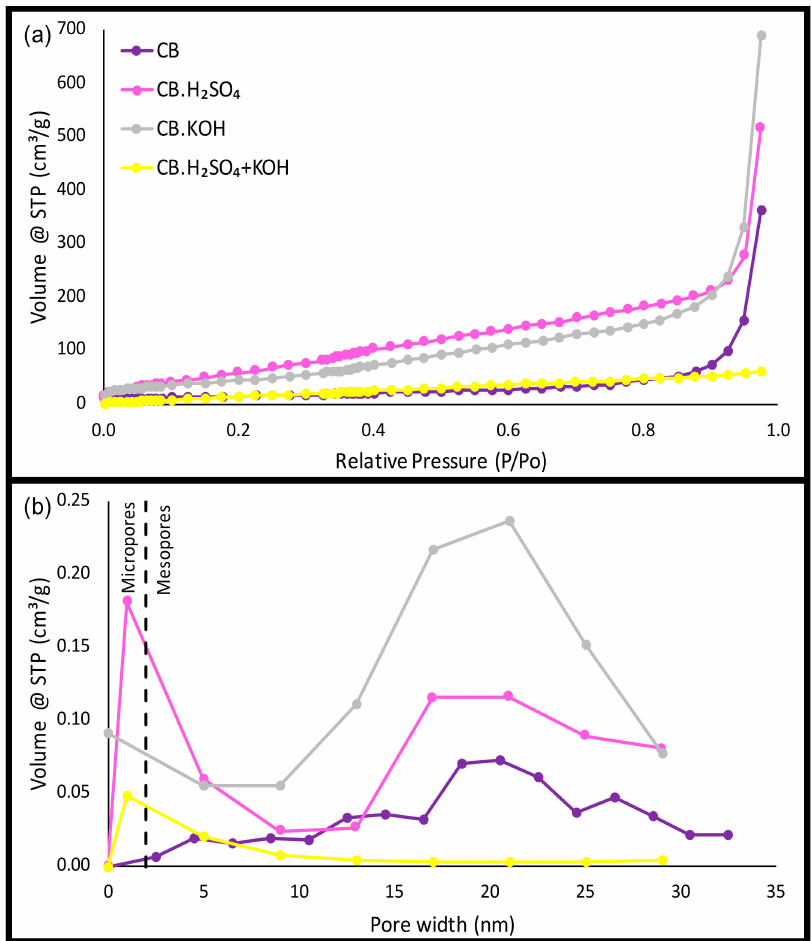
Figure 3. ( a ) N 2 adsorption / desorption isotherm and ( b ) pore size distribution of carbon black